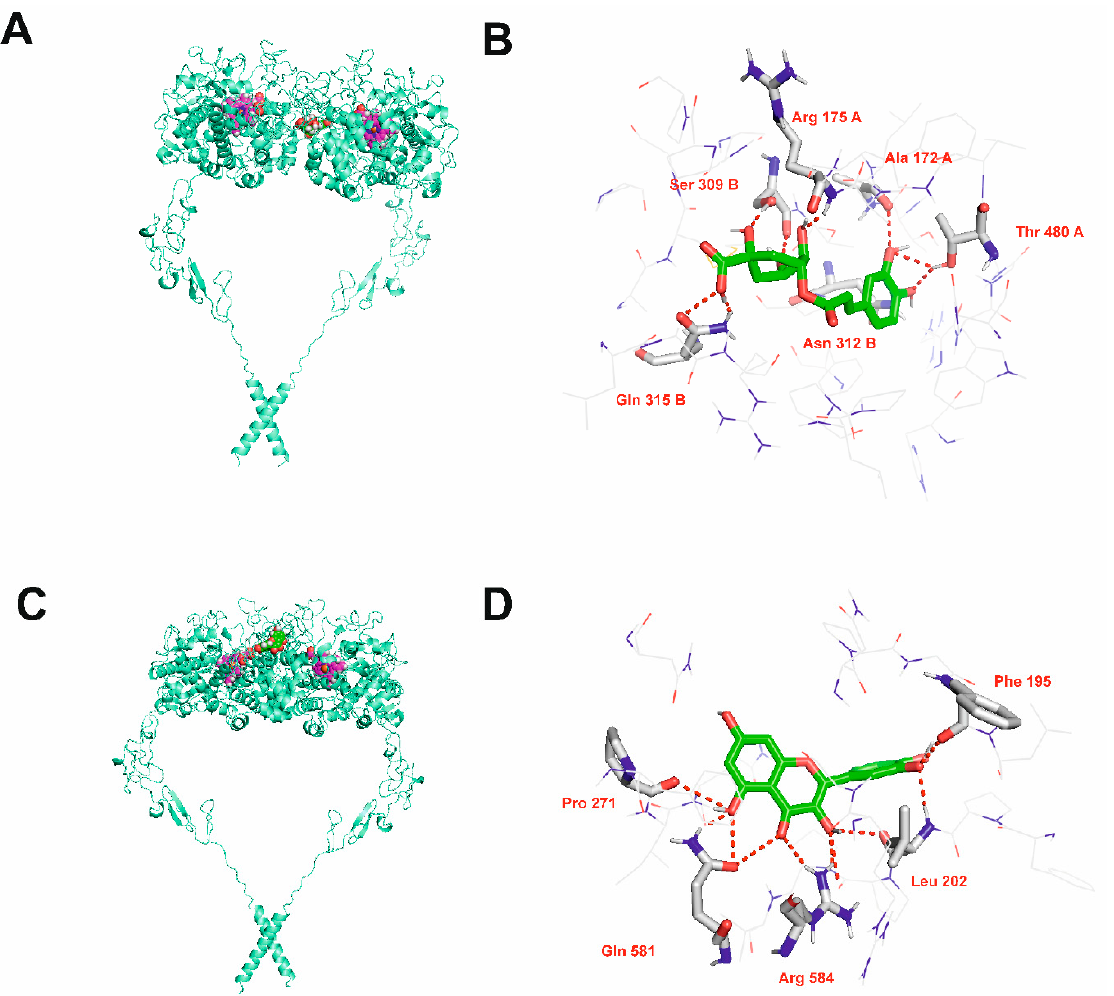
Figure 4. Results of blind docking of chlorogenic acid ( A , B ) and quercetin ( C , D ) to TPO. Parts A and C show general position of the binding site. Protein shown in cartoon representation. Heme and inhibitors shown as spheres with magenta and green carbon atoms, respectively. Parts B and D show details of the binding site. Inhibitor molecules shown as sticks with green carbon atoms. Protein presented in wire representation with grey carbon atoms. Most important residues shown as sticks. Hydrogen bonds depicted as red dashed lines. Non-polar hydrogen atoms omitted for clarity.